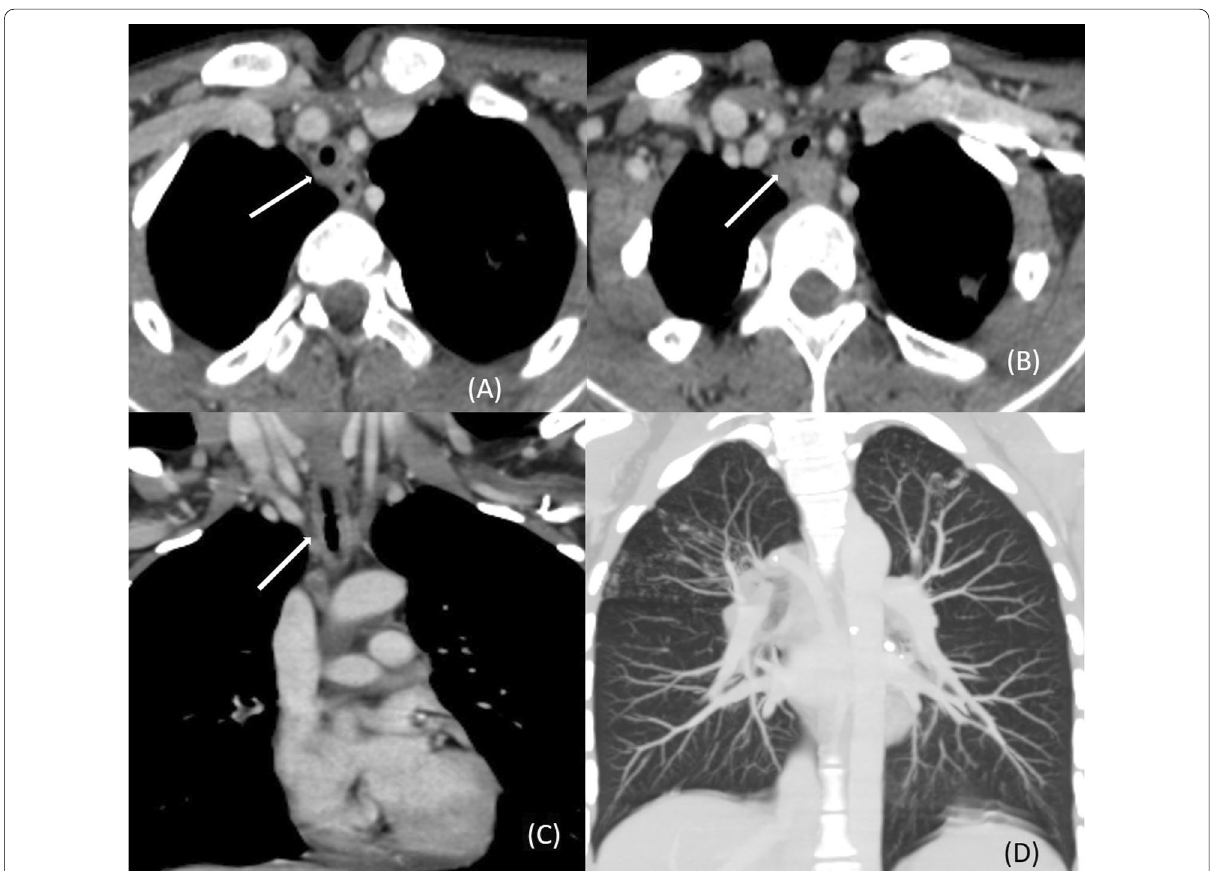
Fig. 7 Tubercular tracheitis. CT images of a 23-year-old female show circumferential wall thickening of distal trachea (white arrow in A – C ) and lung window shows tree-in-bud nodules in the right upper lobe ( D